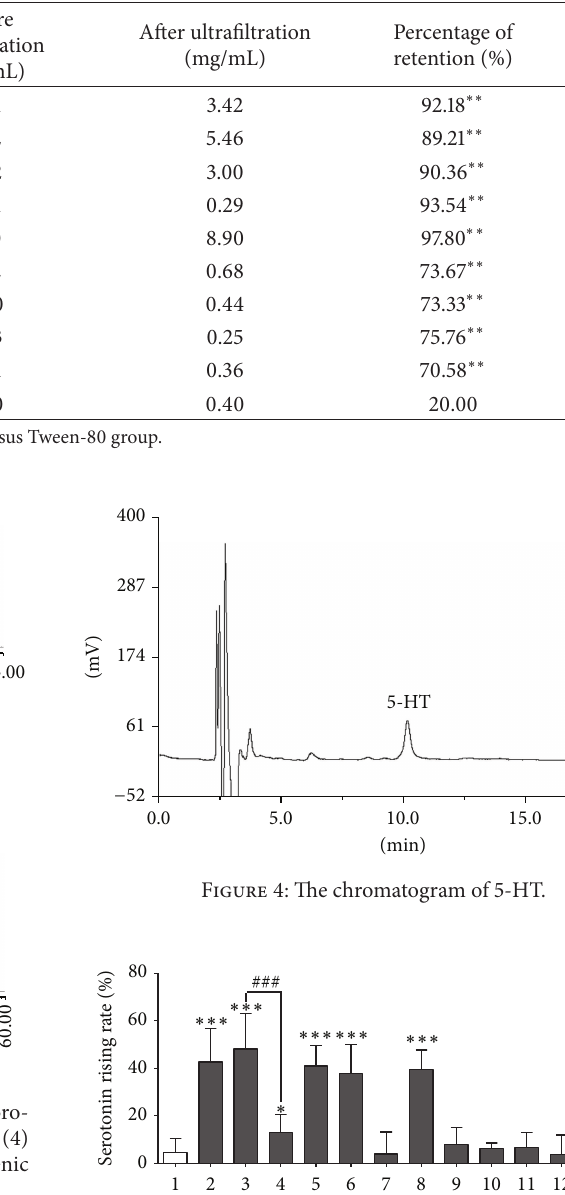
Table 5: Concentration and percentage of retention of each component before and after ultrafiltration.